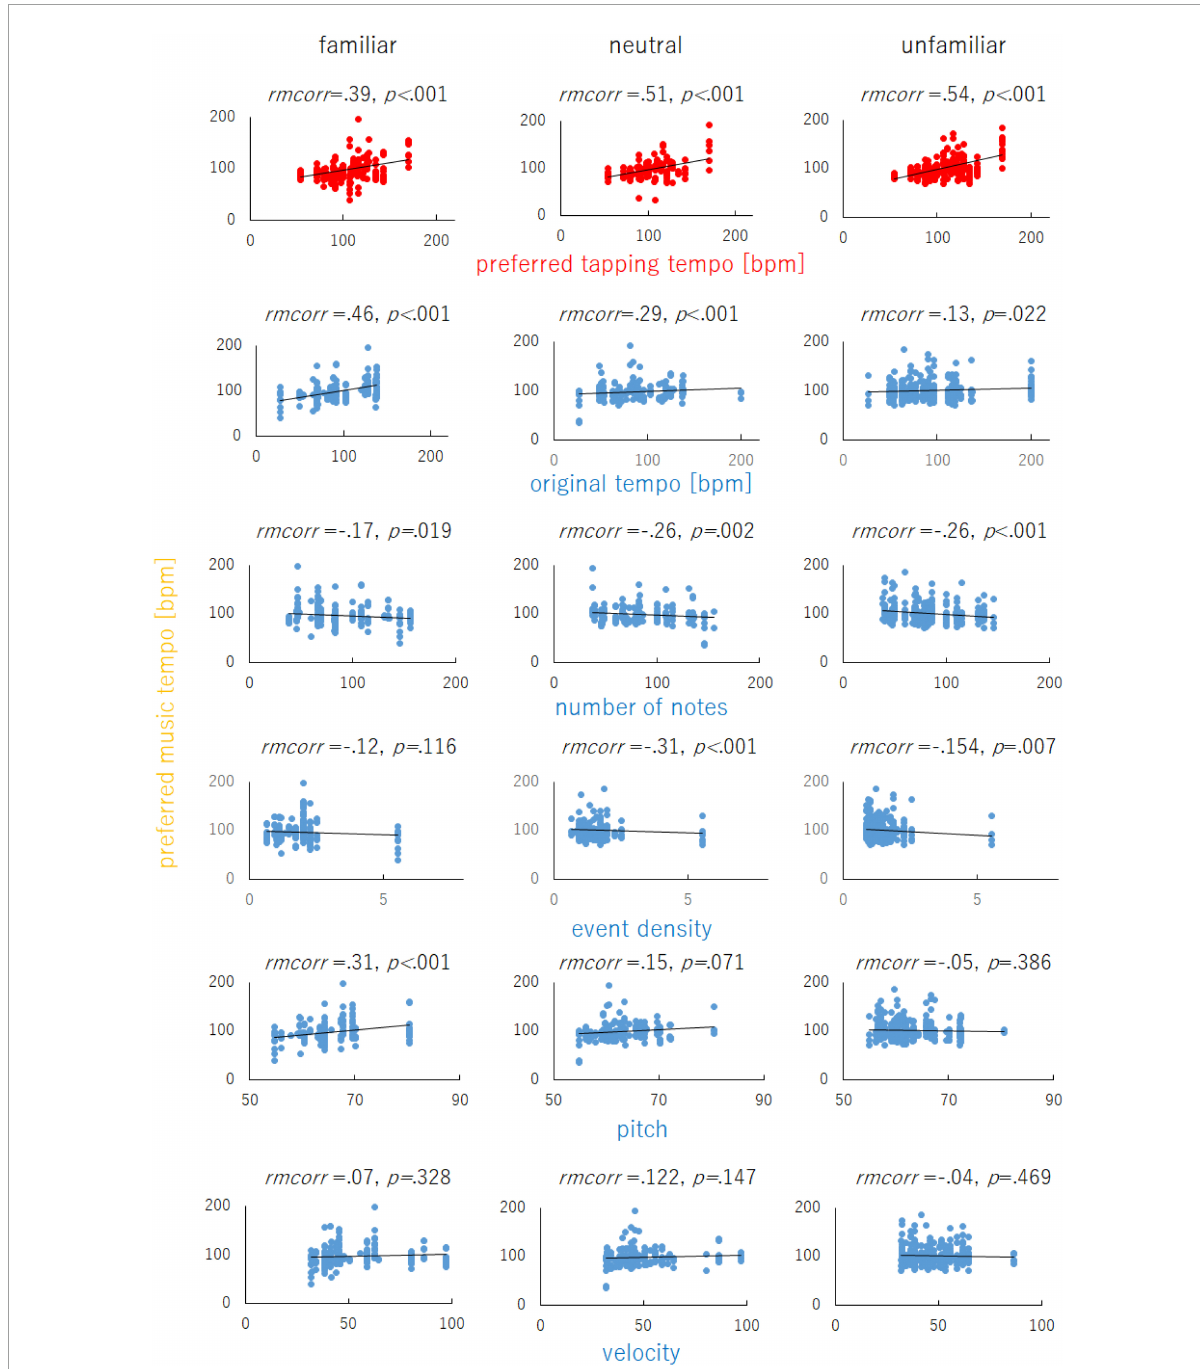
FIGURE2 The relationships of the preferred tapping tempo and music components (original tempo, number of notes, event density, pitch, and velocity) with the preferred music tempo for music in the three familiarity categories (familiar, neutral, and unfamiliar). The lines on each graph represent linear fitting curves. Repeated measures correlation (rmcorr) was calculated using the R package “rmcorr”.